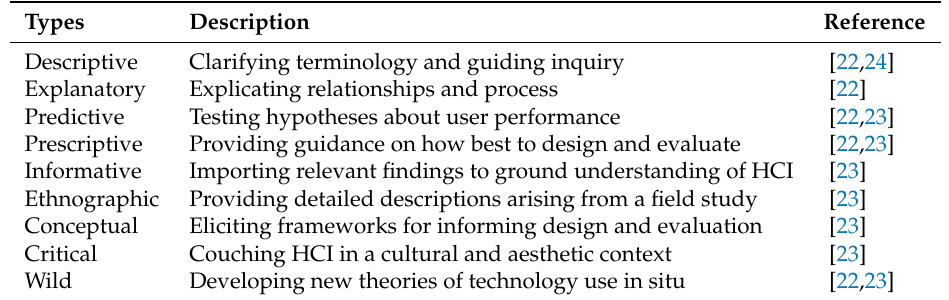
Table 1. A summary of the ways theory has been used and developed in Human–Computer Interaction